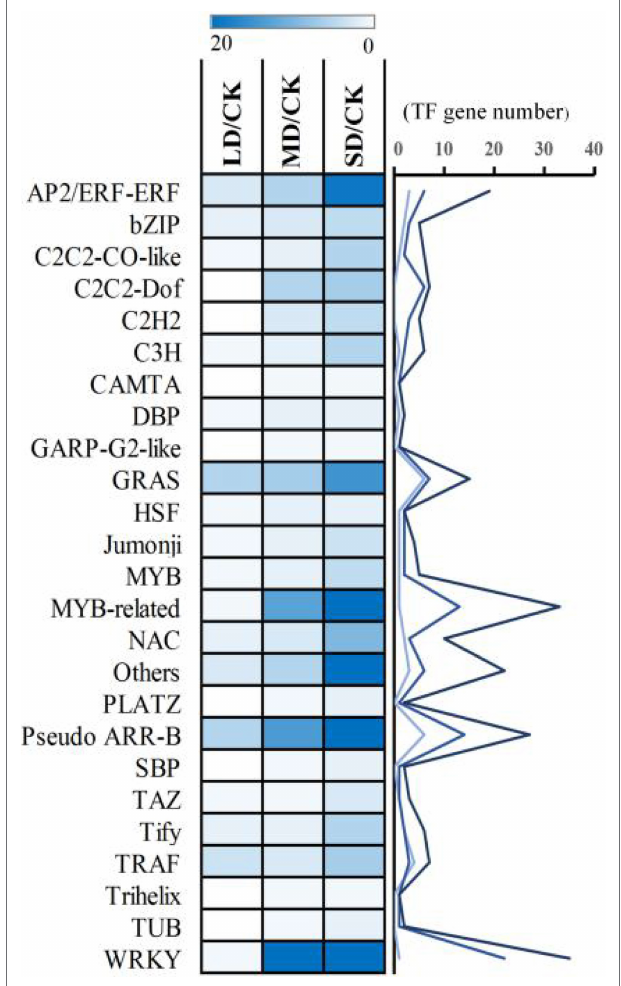
FIGURE 8 | Dynamics of common transcription factor (TF) accumulation